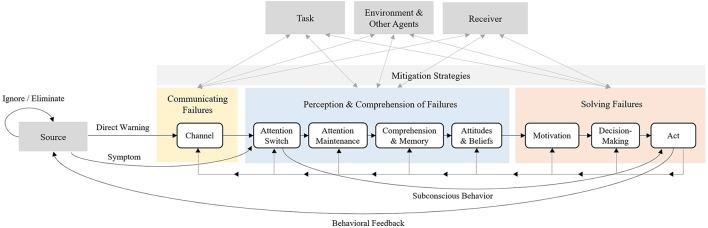
The RF-HIP Model.